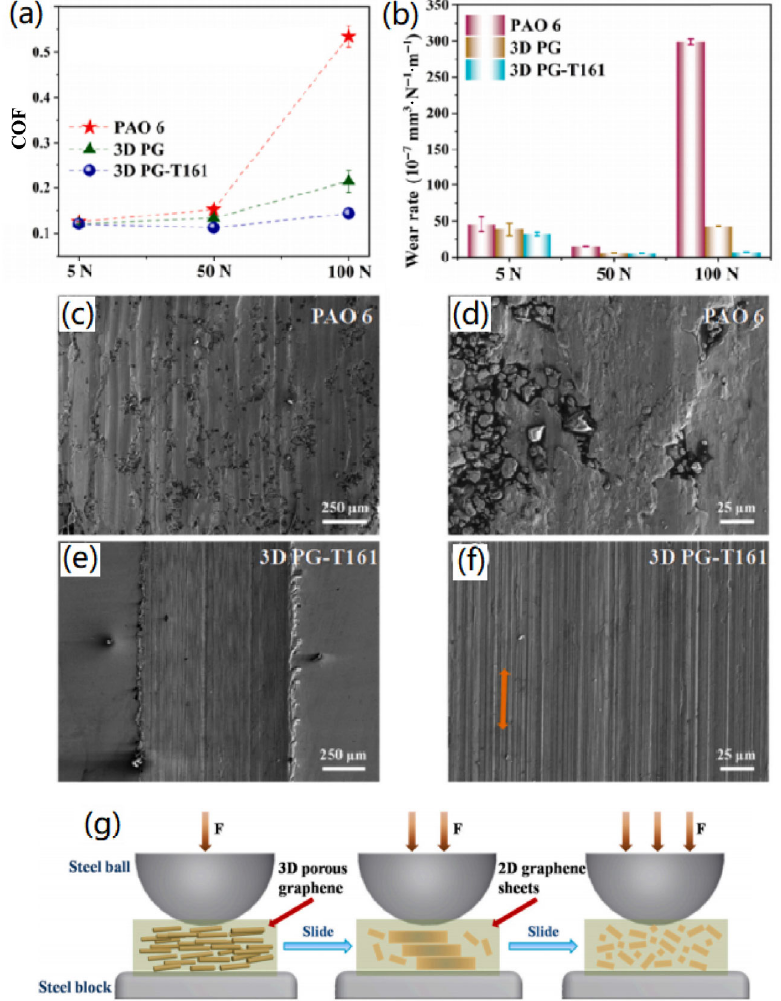
Fig. 10 (a, b) Changes in average COF and wear rate; (c–f) SEM images of wear track surfaces; and (g) schematic diagram. Reproduced with permission from Ref. [162], © Elsevier Ltd.